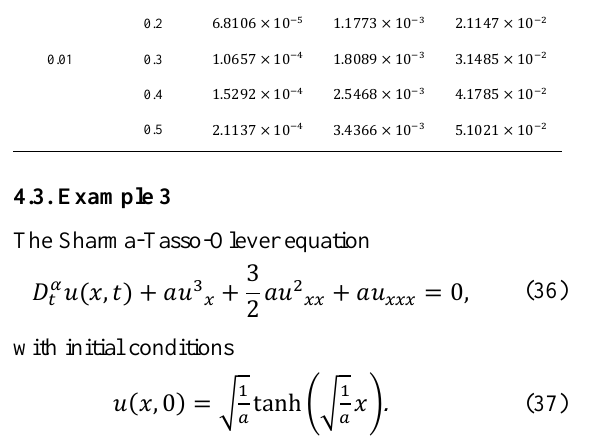
Figure 5. 𝑢(𝑥, 𝑡) versus 𝑡 for Ex. 2 at ℏ = −1, 𝑥 = 5, B 0 = 1,𝜆 = 2, 𝑎 = 1, and 𝑛 = 1 for distinct 𝛼 .